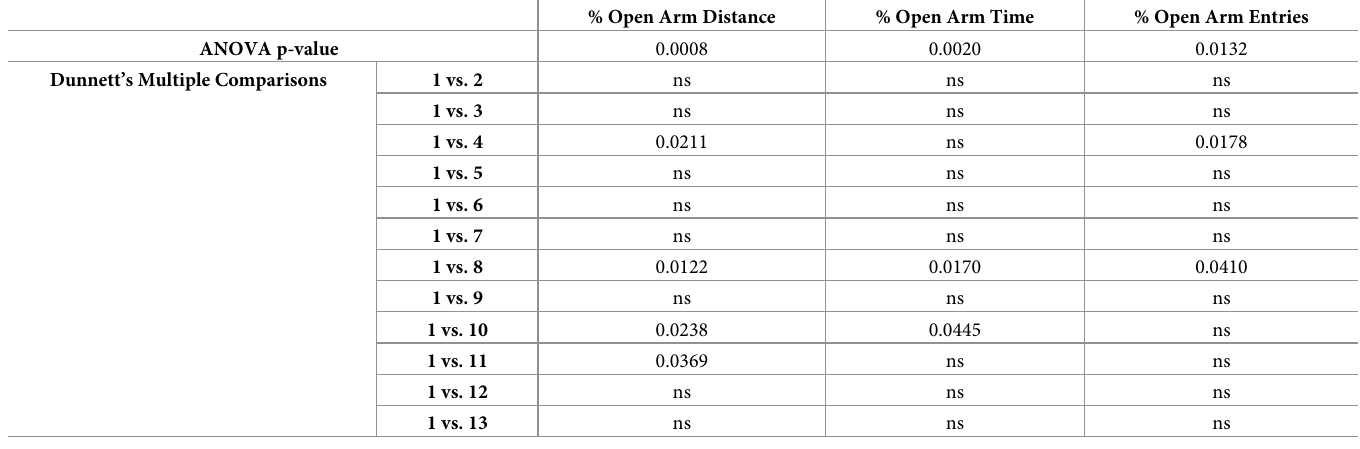
Table 2. Statistical results of open arm preference from Experiment 1. Repeated-measures one-way ANOVA and Dunnett’s post-hoc test results showing main effects of time across repeated trials for percent of total distance travelled in the open arms, percent of total time spent in the open arms and percent of total entries made to the open arm across 13 EPM trials. Trials not significantly different compared to the first trial are reported as “ns,” and trials that do differ significantly from the first trial are reported with an associated